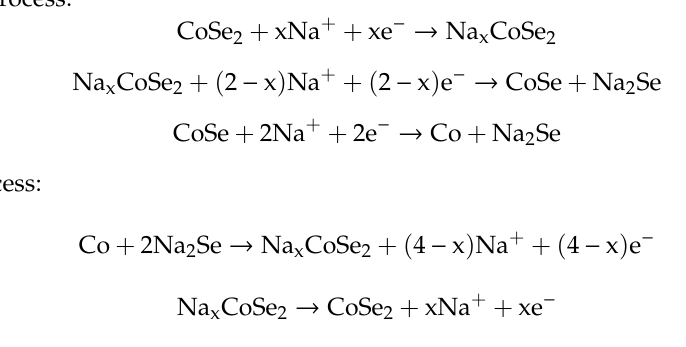
Figure 3. CV curves of ( a ) shale-like Co 3 O 4 tested at 0.1 mV / s from 0.005 to 2.9 V vs. Na / Na + [35]. ( b ) CoP@C-RGO-NF tested at 0.1 mV / s in the voltage range of 0.01–3 V vs. Na / Na + [27]. ( c ) CoS 2 / rGO at a scan rate of 0.5 mV / s from 0.01–3 V vs. Na / Na + [49]. ( d ) CoSe 2 @C / carbon nanotubes (CNTs) tested at 0.1 mV / s from 0.5–2.9 V